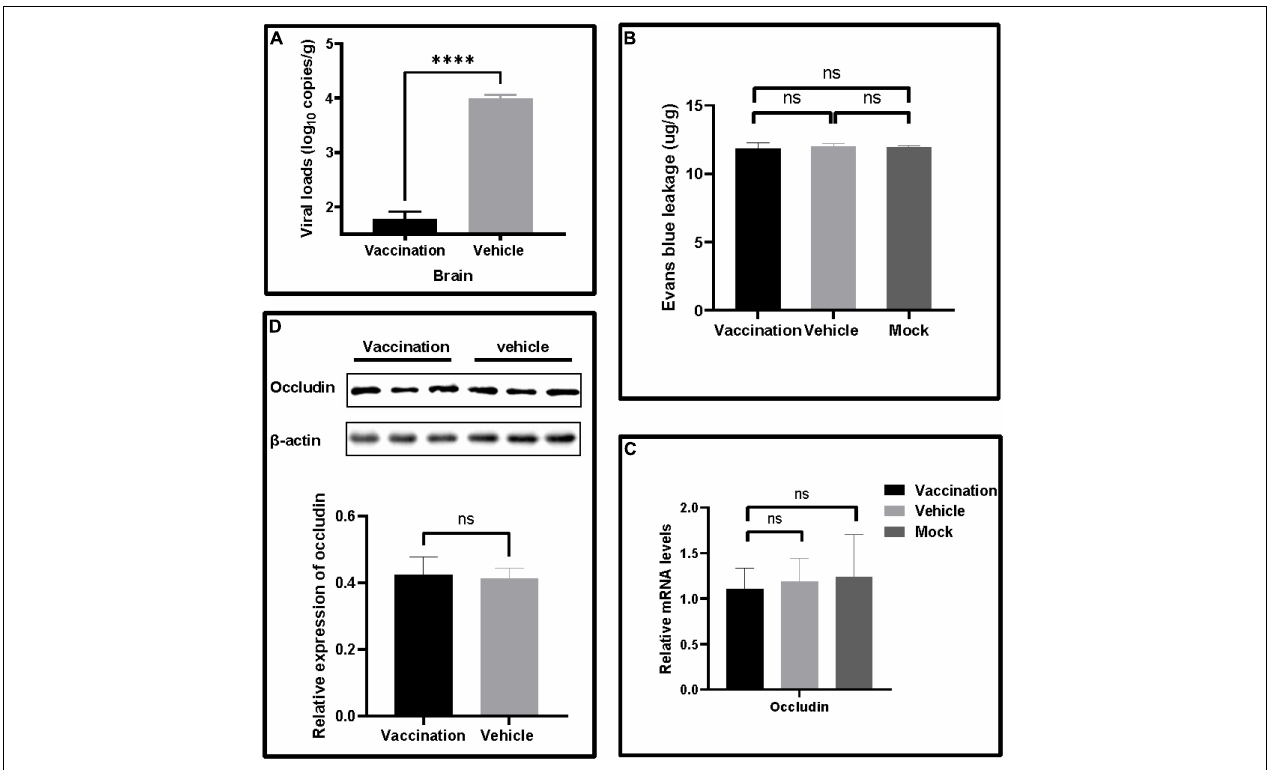
FIGURE 3 | The effects on blood–brain barrier leakage after pseudorabies virus XJ challenge. (A) The viral DNA loads in the brain were determined by qRT-PCR. (B) Quantitative analysis of Evans blue dye extravasation. (C) The fold changes normalized with β -actin as an internal control of occludin mRNA levels in the brain after the challenge. (D) Western blot analysis and relative quantification of the band density of occludin. Data represent mean ± SD. **** p < 0.0001.